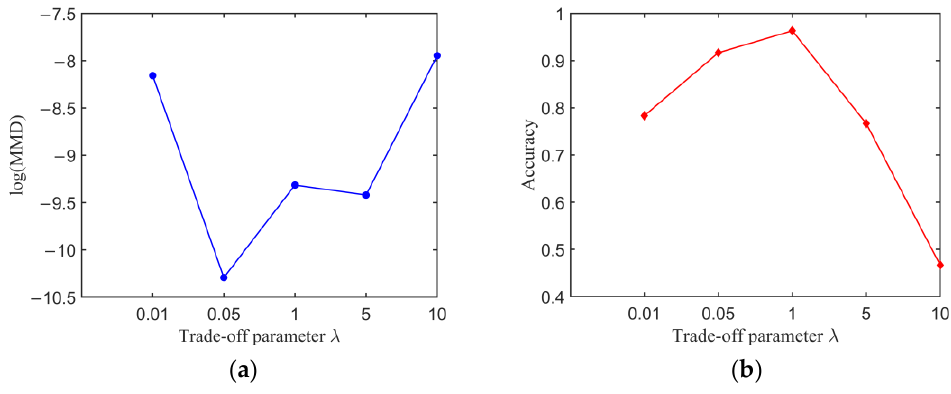
Figure 12. Transfer results of MMD-DANN model with different trade-off parameter λ : ( a ) MMD of the extracted features and ( b ) classification accuracy.